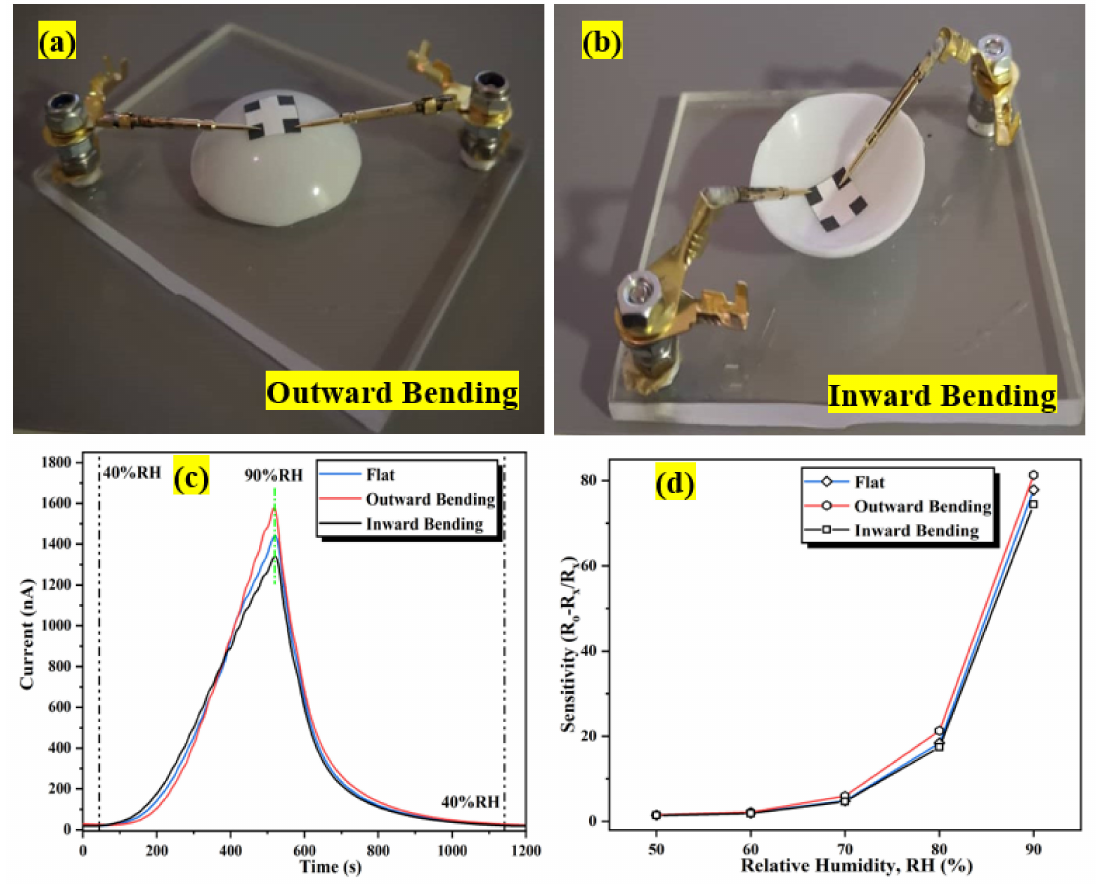
Figure 19. Configuration of the bending assessment: ( a ) outward bending; ( b ) inward bending. ( c ) Dynamic humidity-sensing response variation after distinct bending conditions. ( d ) Sensitivity profiles at different humidity levels (%RH) under flat and bending conditions.